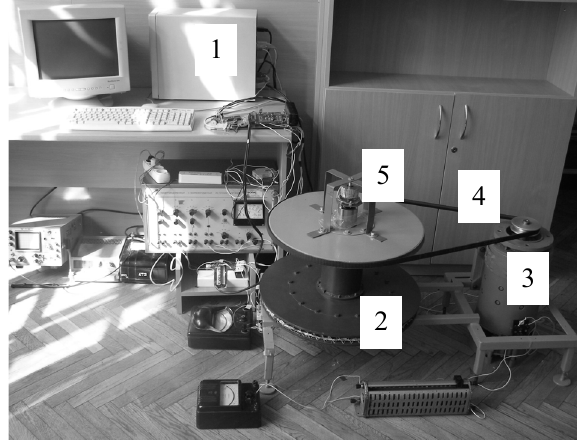
Figure 8. Experimental installation (1) computer control system; (2) SPMSM; (3) DC-machine load; (4) belt connection; (5) encoder.